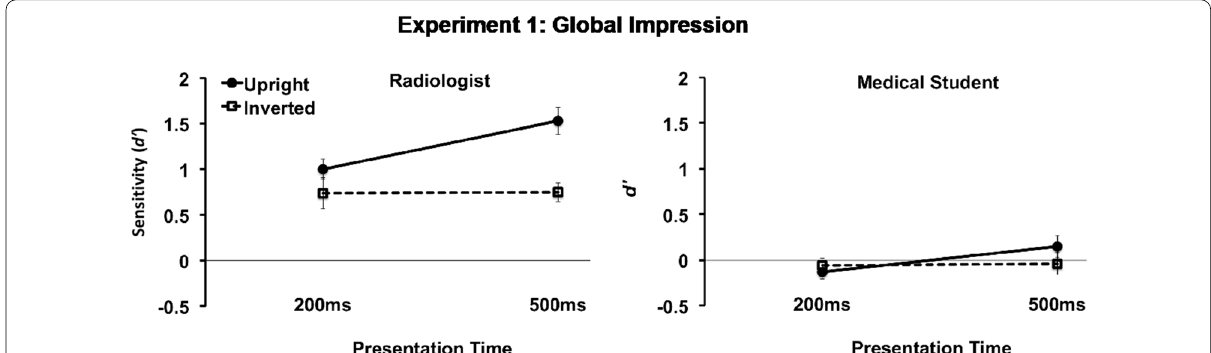
Fig. 2 Experiment 1 (Global Impression) results. Performance, as measured by sensitivity d ′ , on the global impression task for radiologists (left) and medical students (right) on upright and inverted X-rays presented for 200 ms and 500